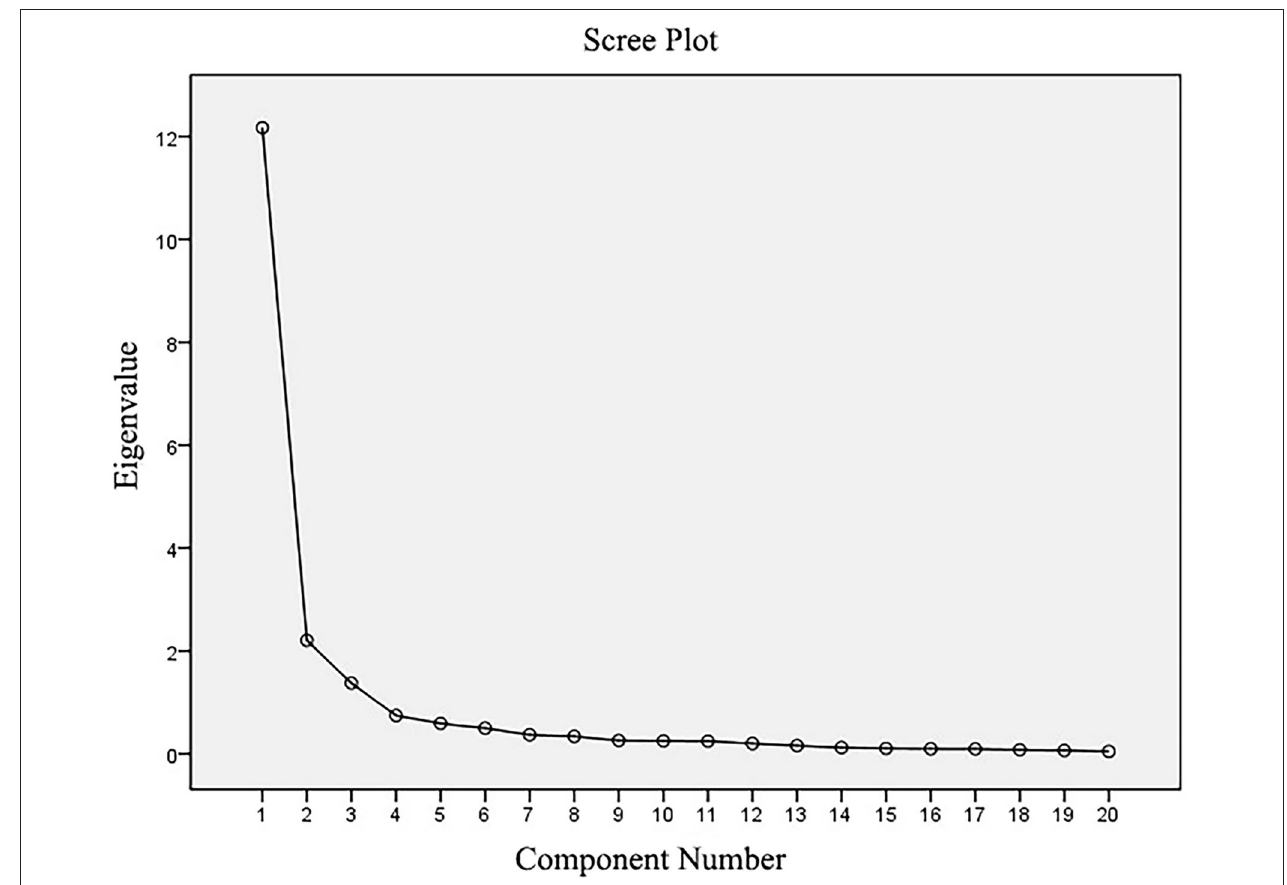
FIGURE 2 | Scree plot from the factor analysis of the disability assessment tool based on the